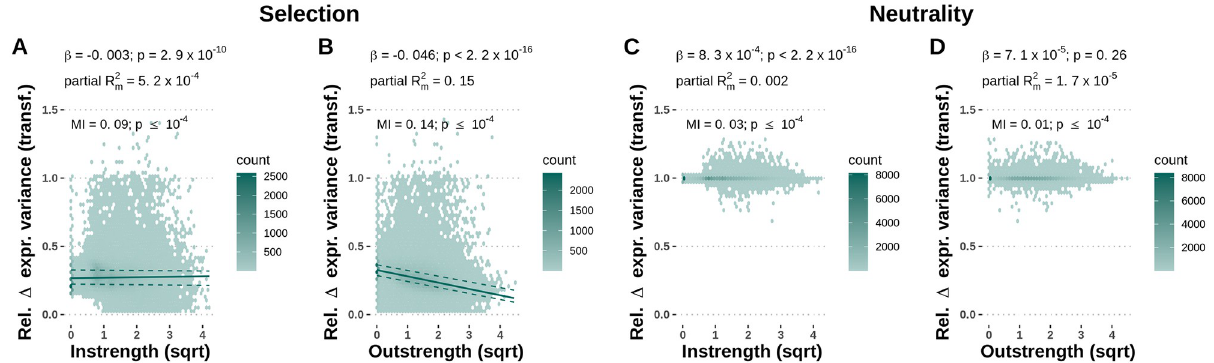
Fig 4. Node-level network centrality measures affect the relative change of gene-specific expression variance under network-level selection. For each gene, the relative change of expression variance before and after evolution (Rel. Δ expr. variance) was averaged over all replicates. A, B —Absolute instrength (A) and absolute outstrength (B) have a significant negative effect on the relative change in gene expression variance in populations evolved under selection. A lower value of relative change of expression variance indicates a bigger reduction in expression variance between the first and last generation and a stronger response to selection. The lines indicate the 25% (lower dashed line), 50% (solid line), and 75% (upper dashed line) fitted quantiles. C, D —Absolute instrength (C) and absolute outstrength (D) have a significant, but negligible, negative effect on the relative change in gene expression variance in the populations evolved under neutrality. The dataset consists of 74,443 genes from 2,000 populations with unique 40-gene random network topology samples, which were independently evolved 10 times under selection and 10 times under neutrality. Coefficients, p-values and partial marginal R 2 measures were estimated using linear mixed-effects models with relative change of gene-specific variance as the response variable, instrength and outstrength as fixed effect explanatory variables, and the network topology sample as the random effect explanatory variable. Mutual information (MI) p-values were computed using 10,000